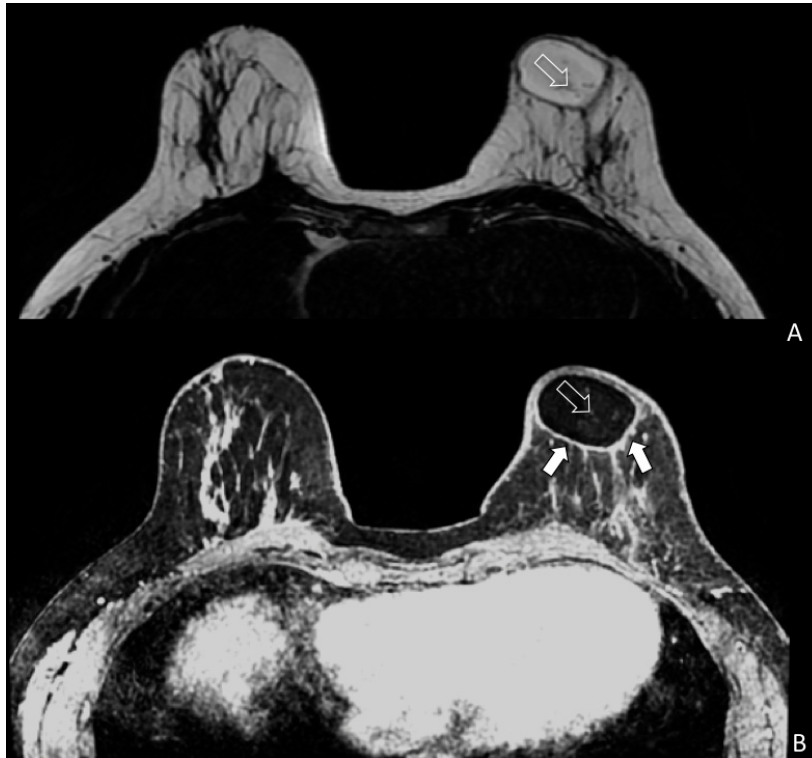
Figure 5. Magnetic resonance imaging (MRI) of a patient (SG) treated with EF-e-A. ( A ) Axial MRI T2-weighted turbo spin echo image of both breasts. Fat is imaged with hyper-intense signal and glandular tissue with the matrix is characterized by hypo-intense signal. In the left breast is showed an oval area of hyper-intense signal representing the fat grafting. Very small vessels are depicted in the area (white empty arrow); ( B ) Bilateral three-dimensional T1-weighted spoiled turbo gradient echo image after contrast media administration VIBRANT sequence showed contrast uptake of the glandular tissue and of the fat graft boundary (white arrows). In this sequence, fat graft is characterized by hypo-intense signal due to the fat saturation pulse. In the fat graft, small vessels characterized by contrast media uptake are confirmed (white empty arrow).